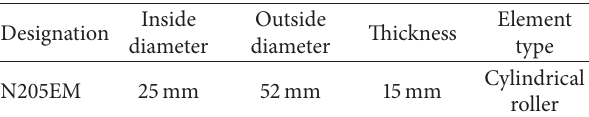
Table 1: Bearing structure information.